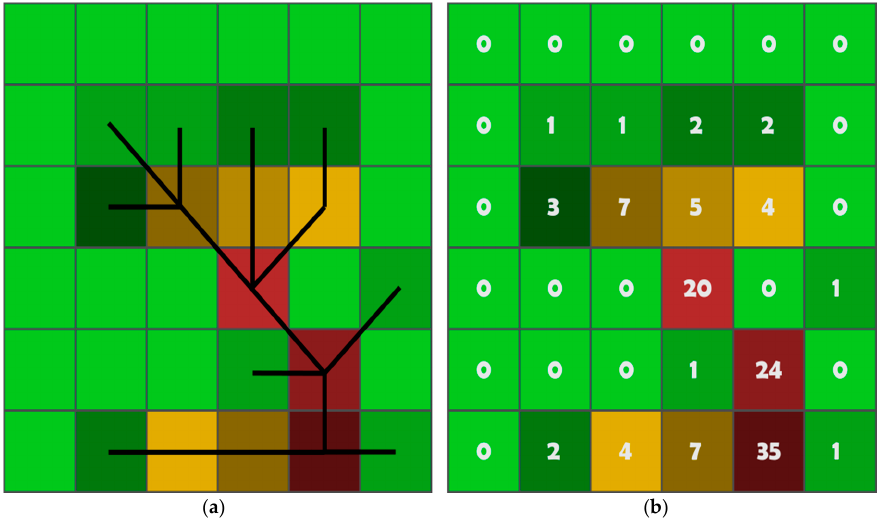
Figure 3. Flow direction overlaid with the flow accumulation raster (Panel ( a )). Flow accumulation numeric representation (Panel ( b )). (Note: the graphical representation of hydrologic flow direction and flow accumulation is not representative of the geographical data presented in this research).